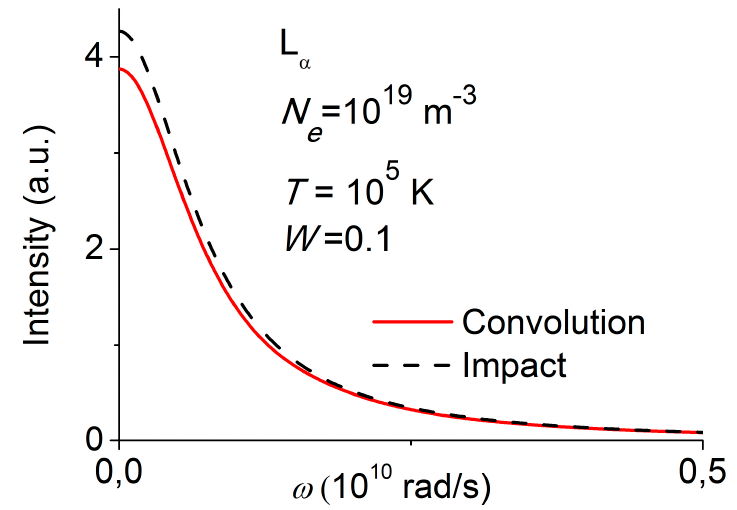
Figure 4. L α in a plasma with a density N e = 10 19 m − 3 , and a temperature T = 10 5 K, calculated with an impact approximation (dashed line), and with a Fourier transform of the DAF in Figure 3 (solid line).